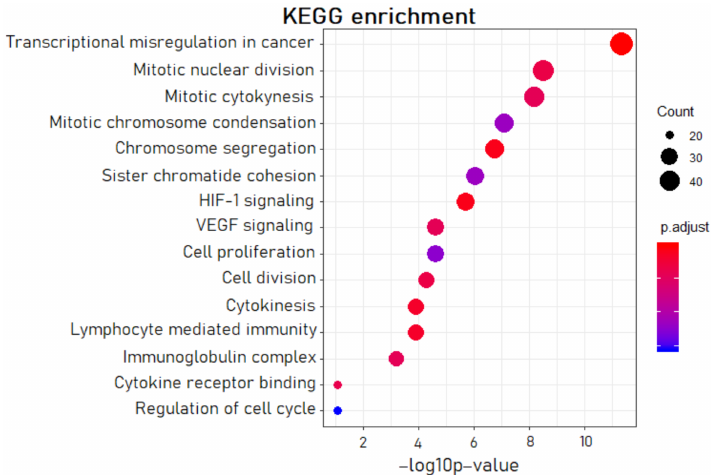
Figure 1. The most significant pathways in OC according to the gene set enrichment analysis (GSEA).